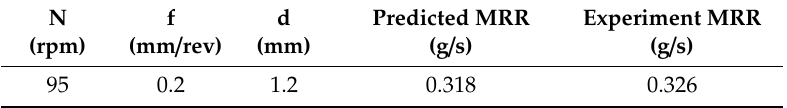
Table 5. Optimum parameter reported by CHP and confirmation experimentation.